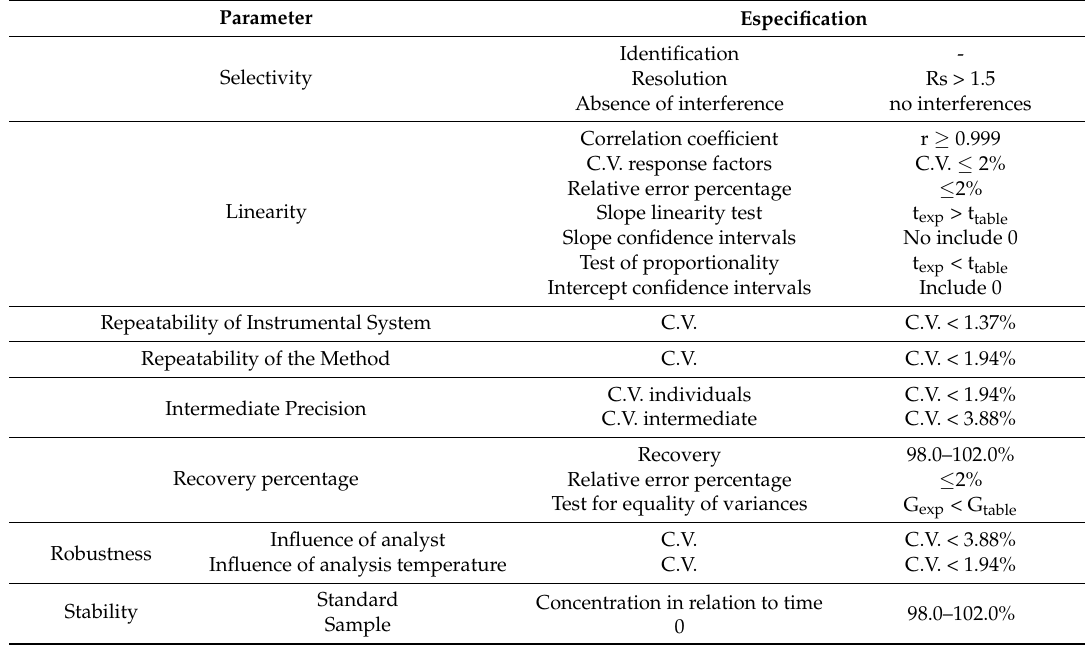
C.V.: Coefficient of variation; G exp : Experimental G value; G table : G value in